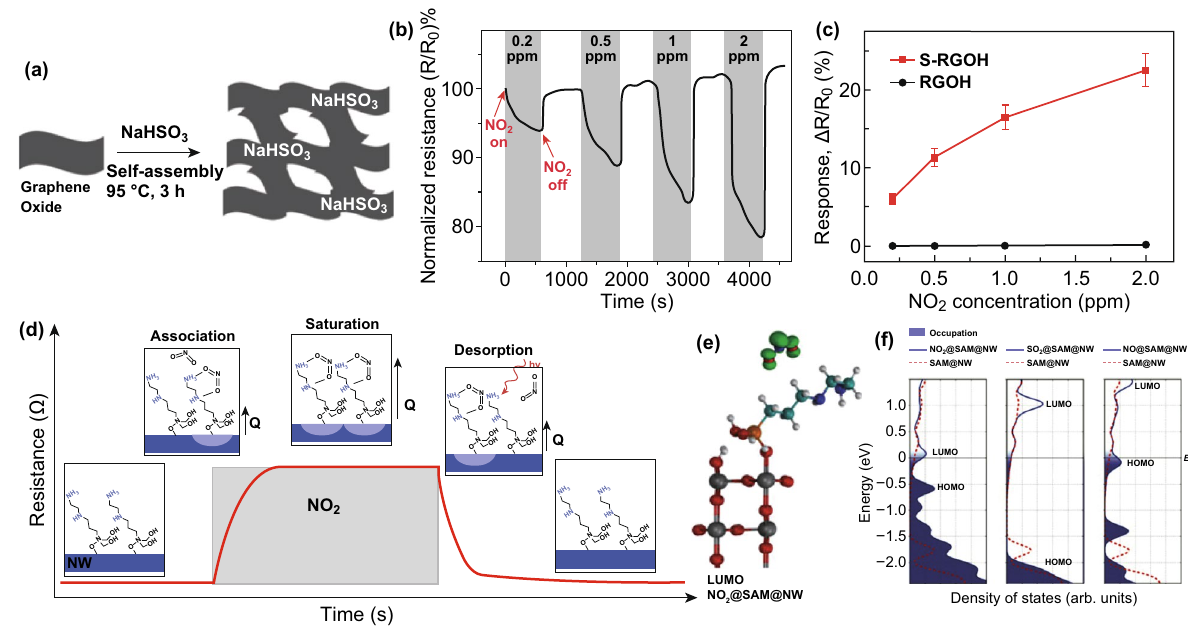
Fig. 14 a Schema of the synthesis of 3D chemically modified graphene hydrogel. b Dynamic response of the 3D S-RGOH sensor versus time after exposure to 0.2–2 ppm NO 2 . c Plots of the quantitative responses of the S-RGOH and RGOH sensors versus NO 2 concentration. Repro- duced with permission [68]. Copyright 2017, Wiley–VCH. d, e Schematic illustration of the NO 2 sensing mechanism by en-APTAS 1-modified NWs. f Density of states (DOS) of the en-APTAS 1-modified SnO 2 with adsorbed NO 2 , SO 2 , and NO. The Fermi levels of the different systems are set at 0 eV. For comparison, the DOS of the en-APTAS 1-modified SnO 2 NW without an adsorbed gas molecule (dashed red line) is shown in each graph. Reproduced with permission [70]. Copyright 2014,